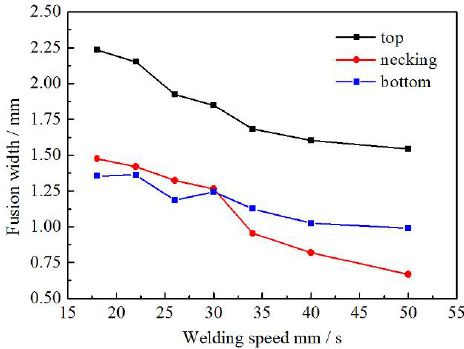
Figure 5. Relationship between the width of FZ and welding speed.